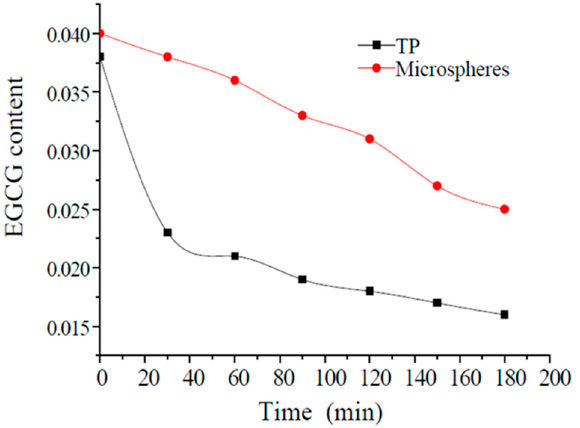
Figure 6. The variation of EGCG content during release process.